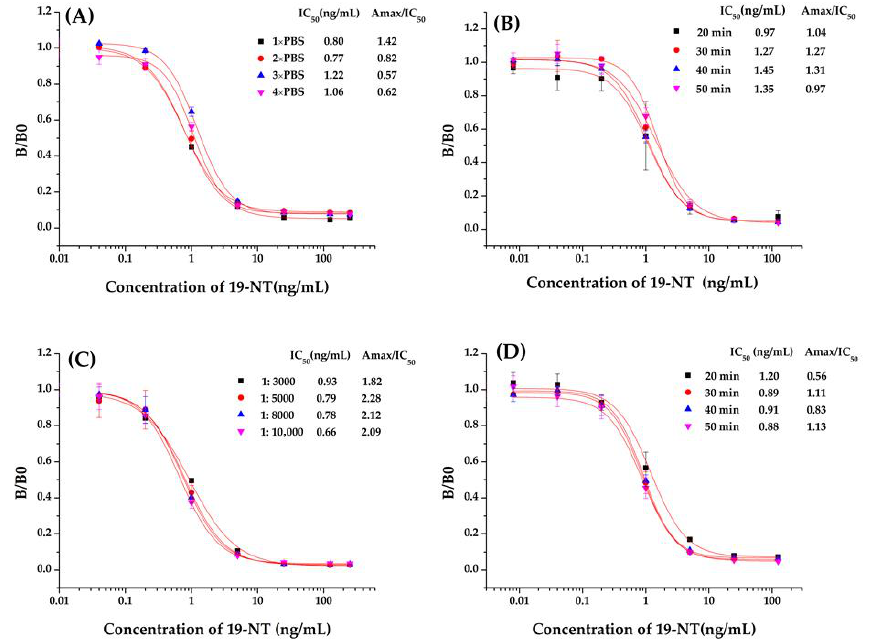
Figure 8. Parameters optimization of ic-ELISA based on Nb2F7. ( A ) Concentrations of PBS, ( B ) Incubating time of anti-19-NT Nb, ( C ) Concentrations of anti-VHH-HRP, ( D ) Incubating time of anti-VHH-HRP.